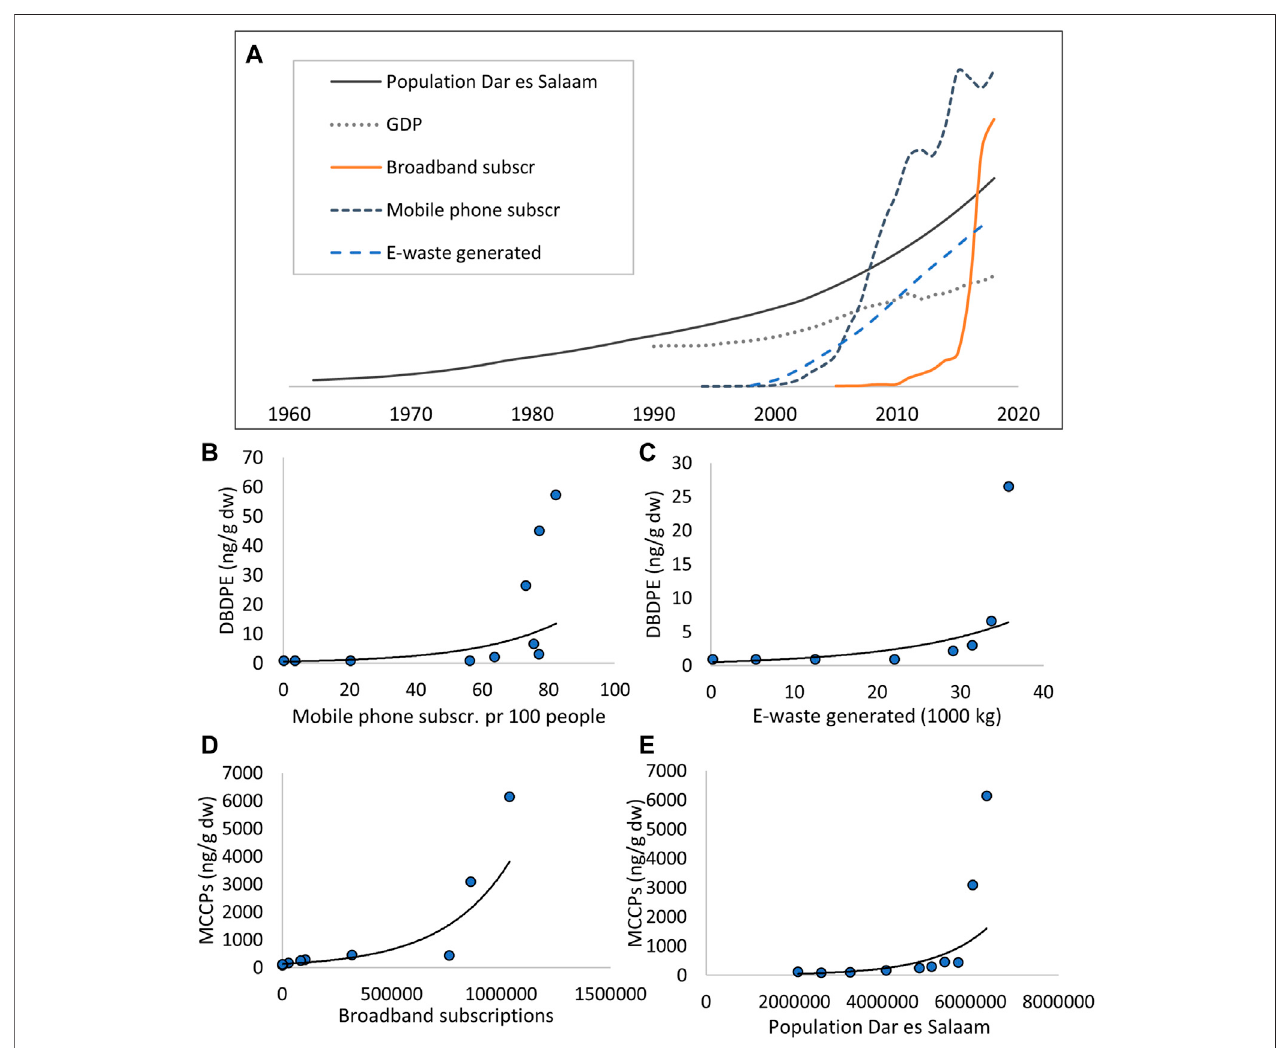
FIGURE4|(A) TimetrendsofsomesocioeconomicfactorsinTanzania(GDP,broadbandsubscriptions,mobilephonesubscriptions,e-wastegenerated)andDar es Salaam (population). For comparison purposes data have been converted to unitless numbers by normalizing using the mean. Original data for population, GDP per capita,Broadbandsubscriptions, and mobile phone subscriptions are gathered from the World Bank (WorldBank, 2021).E-waste data arefrom the Tanzanian National BeaureuofStatistics(NBS,2019). (B , C) ConcentrationsofDBDPEplottedagainst mobilephonesubscriptions ande-wastefrom1998to2019(e-wastedataonly available to 2017). (D , E) : Concentrations of MCCPs plotted against broadband subscriptions and population in Dar es Salaam from 1998 to 2019.